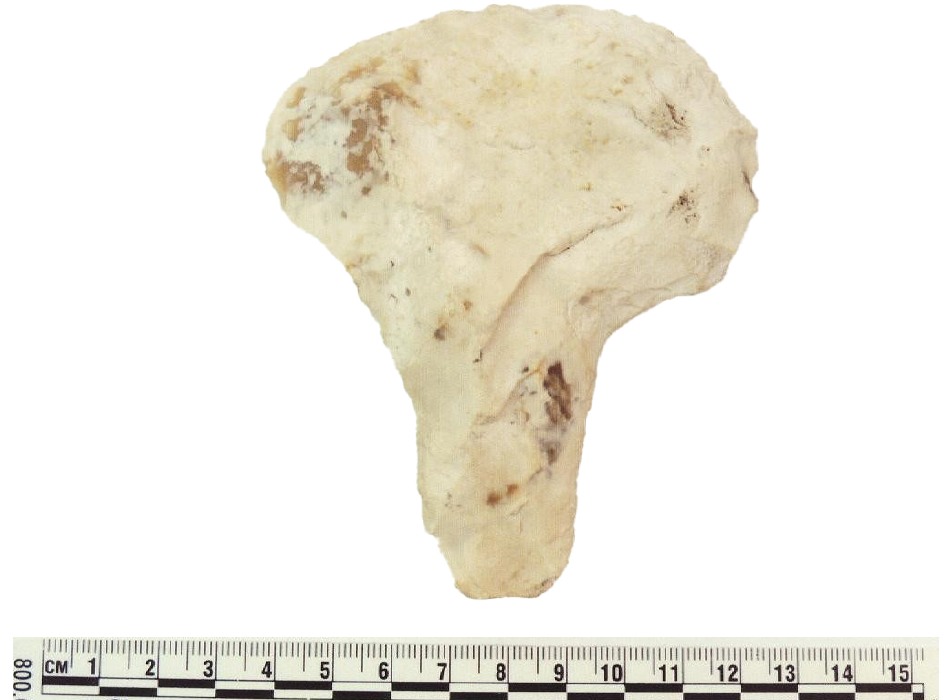
Figure 6. Photograph of Rounded variety made of chert (by Healy, courtesy of Cambridge University, Museum of Archaeology and Anthropology, Cat. No. 1946.166A; scale in